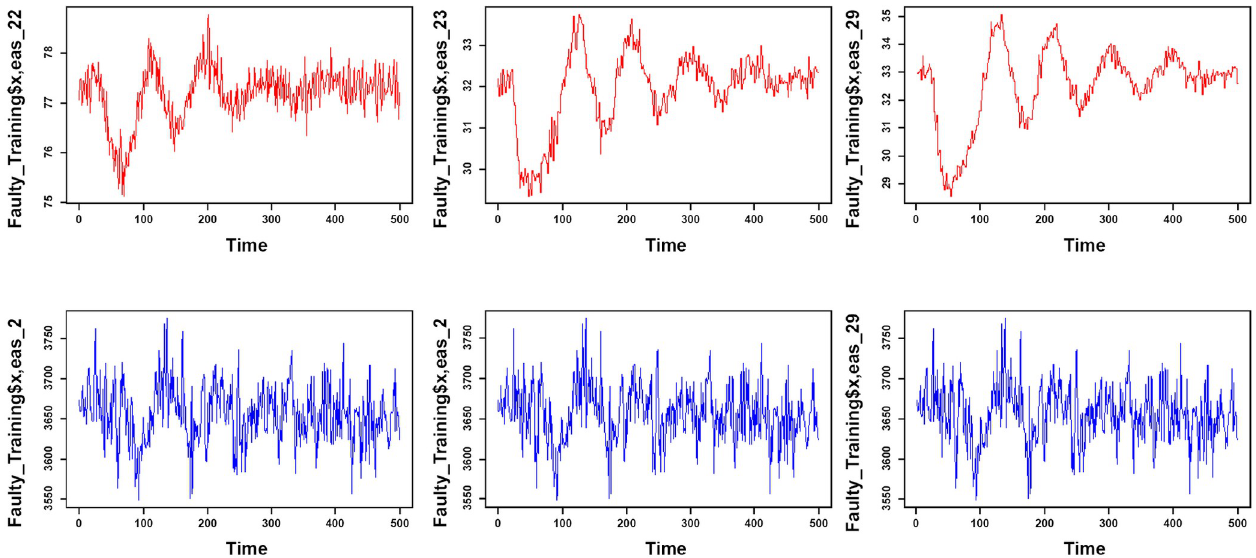
Fig 6. Trends of TEP simulated data for normal process.